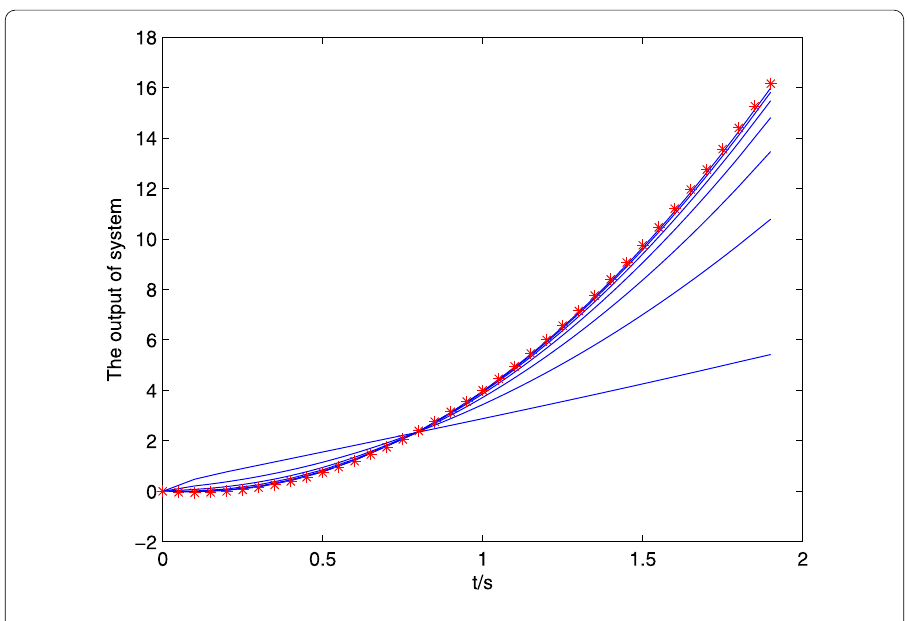
Figure 3 ∗∗∗ denotes the desired trajectory, — denotes the output of the system.